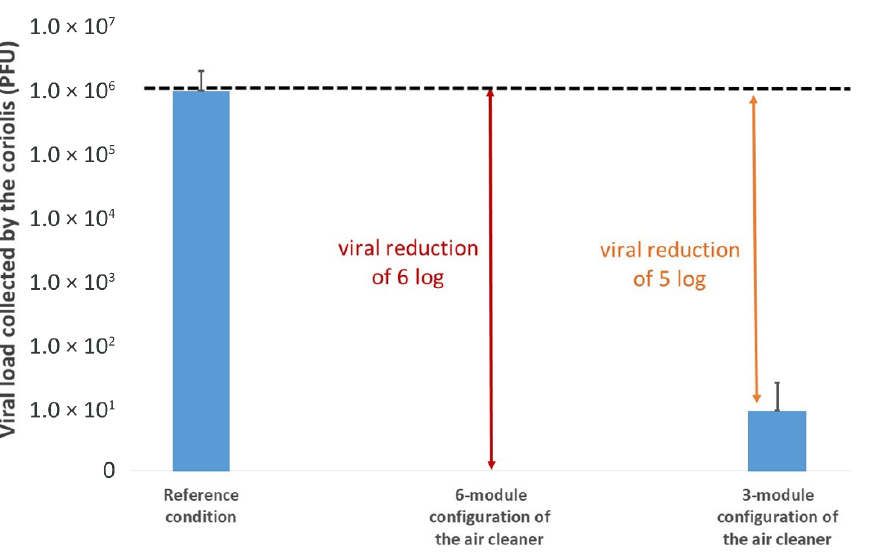
Figure 4. Viral reduction obtained for the different experimental conditions.